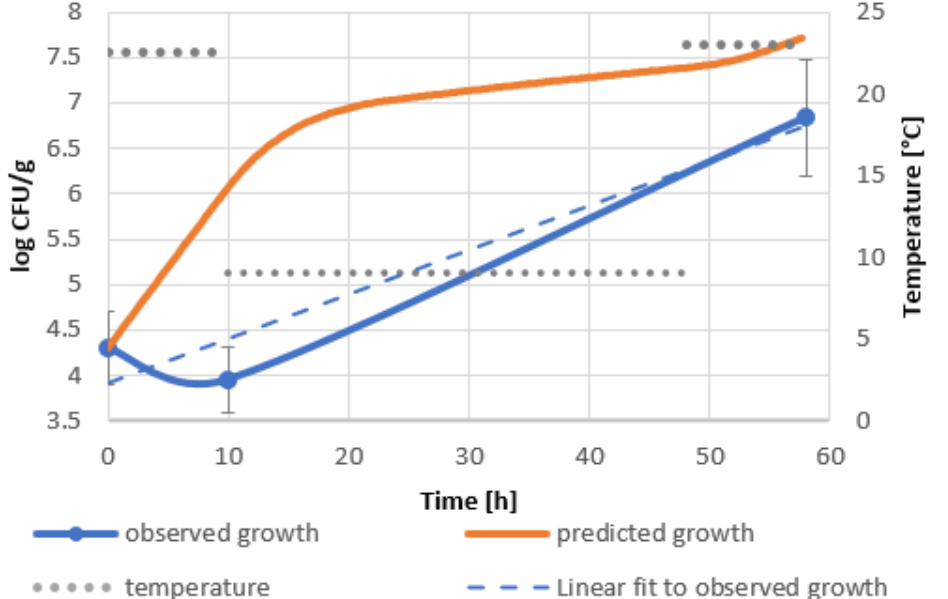
Figure 2. Predicted and real growth of B. subtilis in goji berry extract in temperature shifts, profile II 22.5 ℃–9 ℃–23 ℃ .